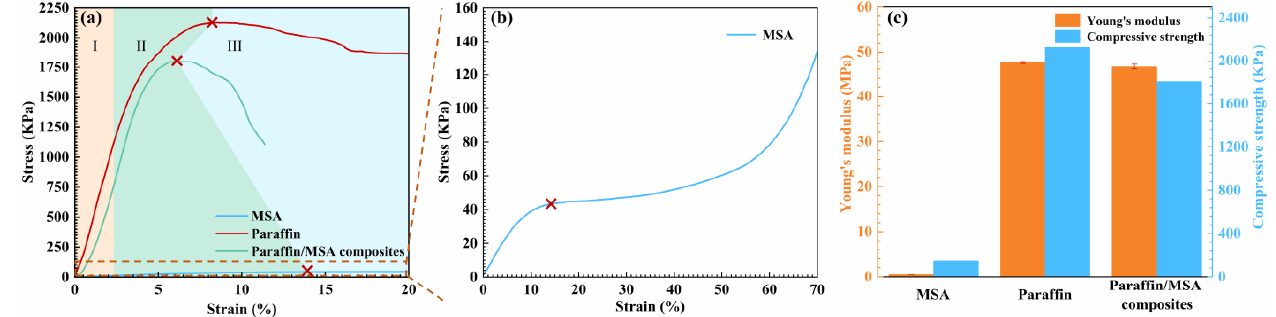
Figure 4. ( a , b ) The compressive stress–strain curves and ( c ) Young’s modulus and compressive strength of the MSA, paraffin and paraffin/MSA composites. The points labeled with red crosses represent the maximum compressive strength and the red dotted line corresponds to the enlarged stress–strain curve region.